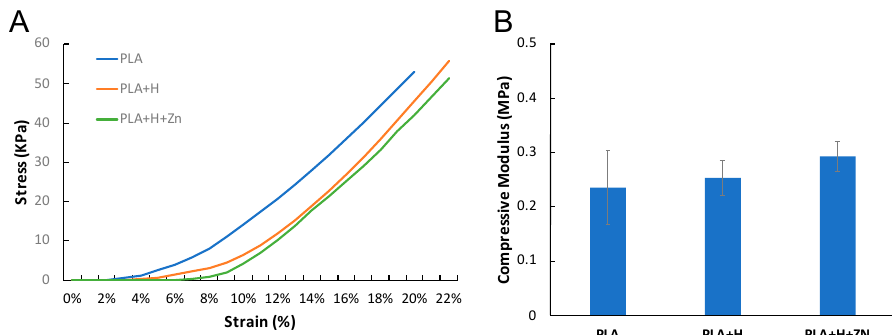
Figure 6. ( A ) Stress vs. strain profile and the compressive modulus of PLA, PLA + H, and PLA + H + Zn. ( B ) The compressive modulus: PLA = 0.24 ± 0.07 MPa, PLA + H = 0.25 ± 0.03 MPa, PLA + H + Zn = 0.29 ± 0.03 MPa (error bar with standard deviation, n = 5).